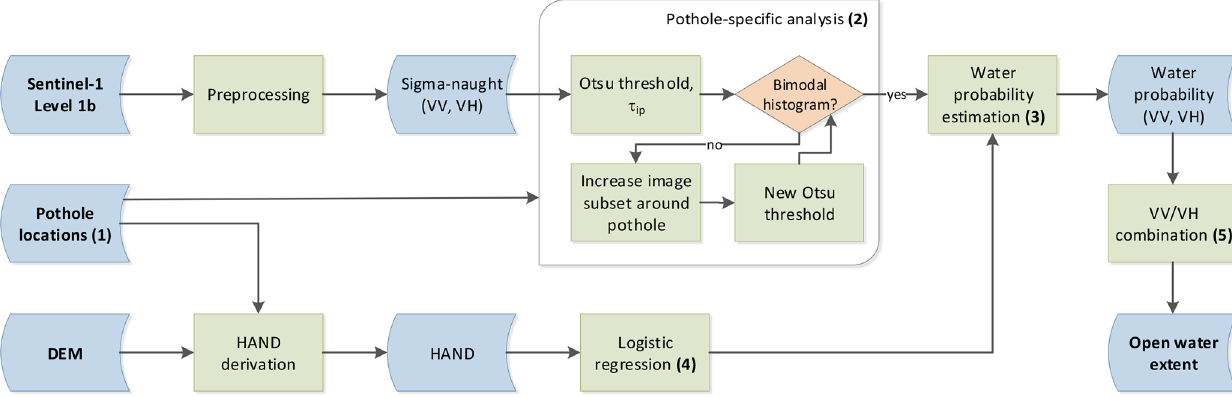
Figure 3. Sentinel-1 processing workflow for dynamic open water classification. Bold numbers in parentheses indicate key datasets and processing steps referred to in the